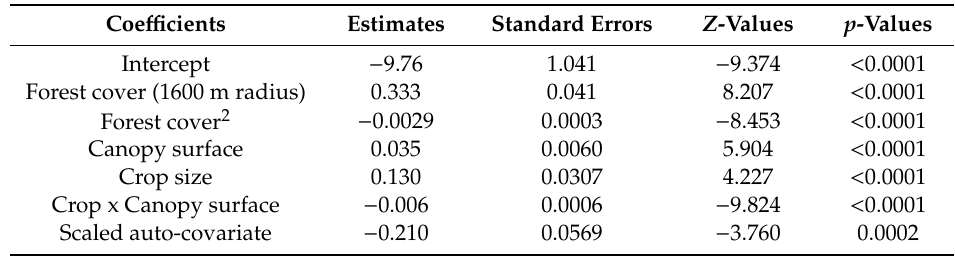
Table 1. Selected auto-covariate logistic regression models of seed removal rate with Efron’s pseudo R-squared and likelihood ratio tests. Helicostylis tomentosa , sample size = 19. Coe ffi cients Estimates